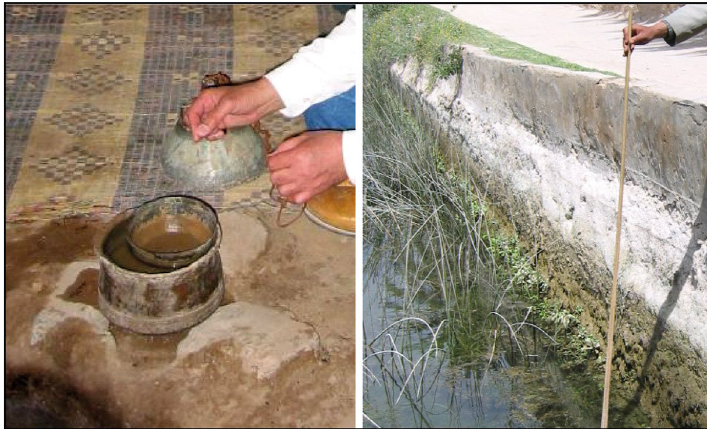
Fig. 6 The hydraulic clock system or Tanast and the graduated stick used as a measuring instrument for the distribution of khettara water (Source: the